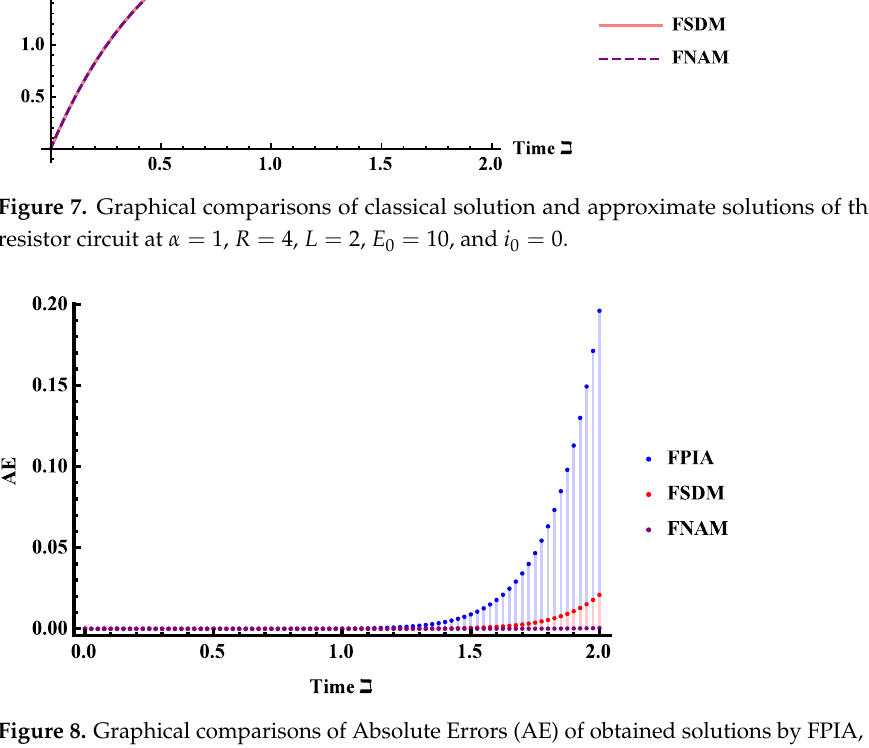
Figure 8. Graphical comparisons of Absolute Errors (AE) of obtained solutions by FPIA, FSDM, and FNAM.